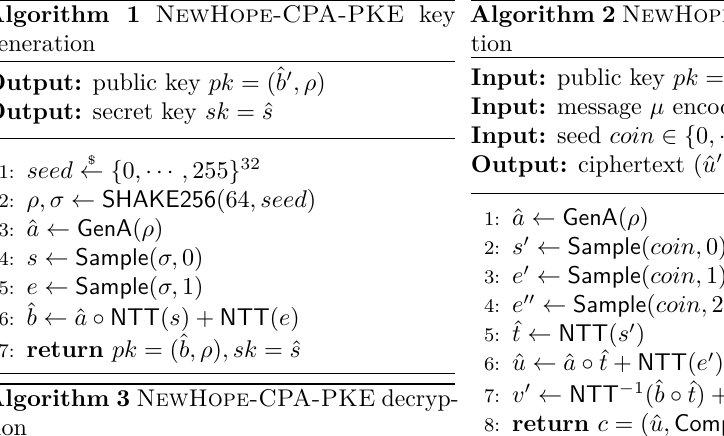
Algorithm 1 NewHope-CPA-PKE key